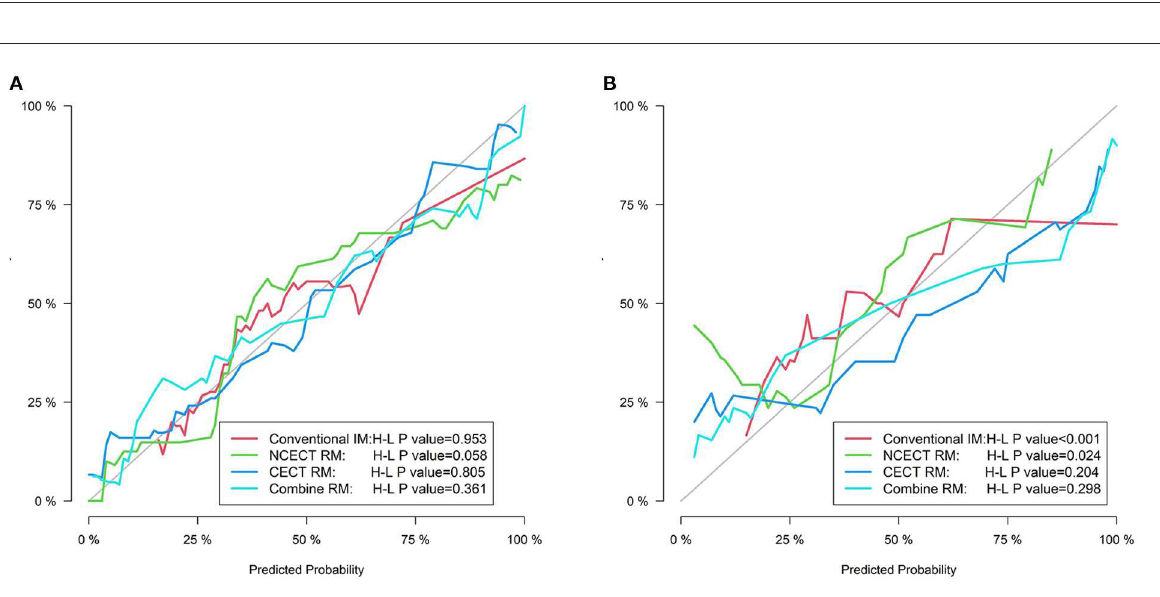
higher risk of acid-fast bacilli positivity as well as being highly infectious